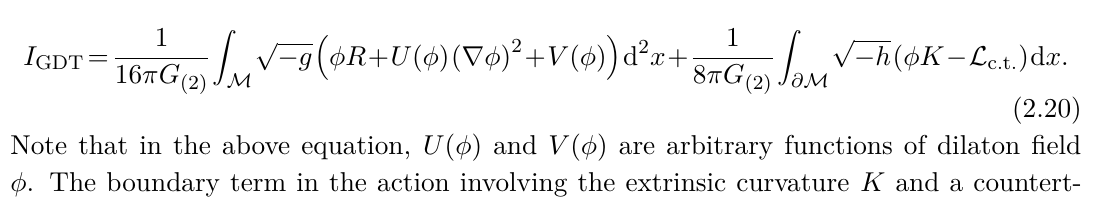
(cid:28) 1 , ( D ) (blue solid BH